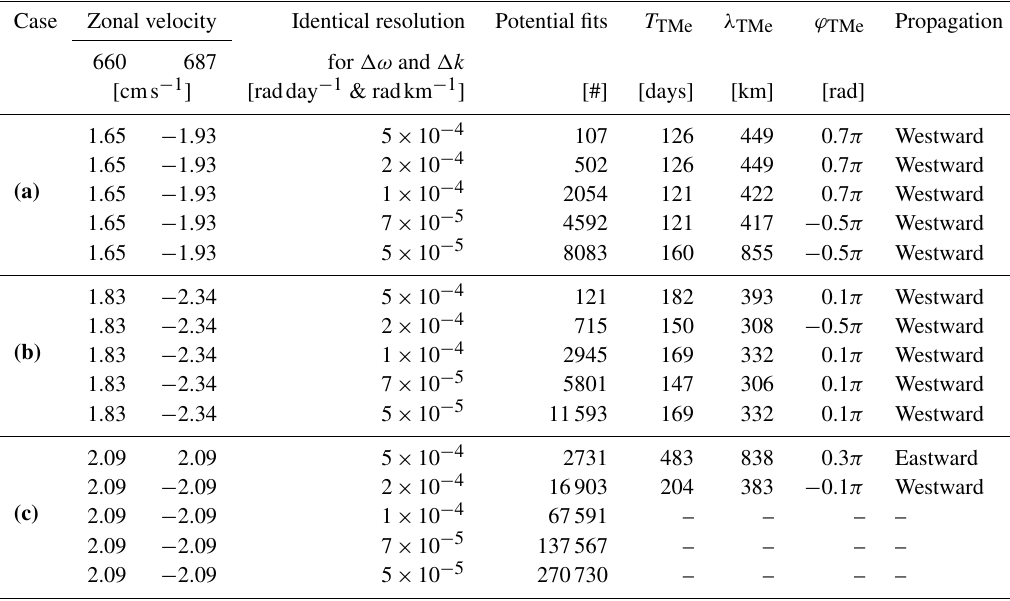
Table A1. Characteristics of the theoretical wave that best fits both 660 and 687 float trajectories for different zonal speed cases and resolution. Case (a) refers to the global mean zonal velocity of each float from the first cycle to the last one for 660 trajectory and from the 58th cycle to the last one for 687 trajectory (see Sect. 2.2). Case (b) refers to the mean of all the measured zonal velocities for each float. Case (c) refers to the mean of all floats (i.e., the mean of all the values obtained in case